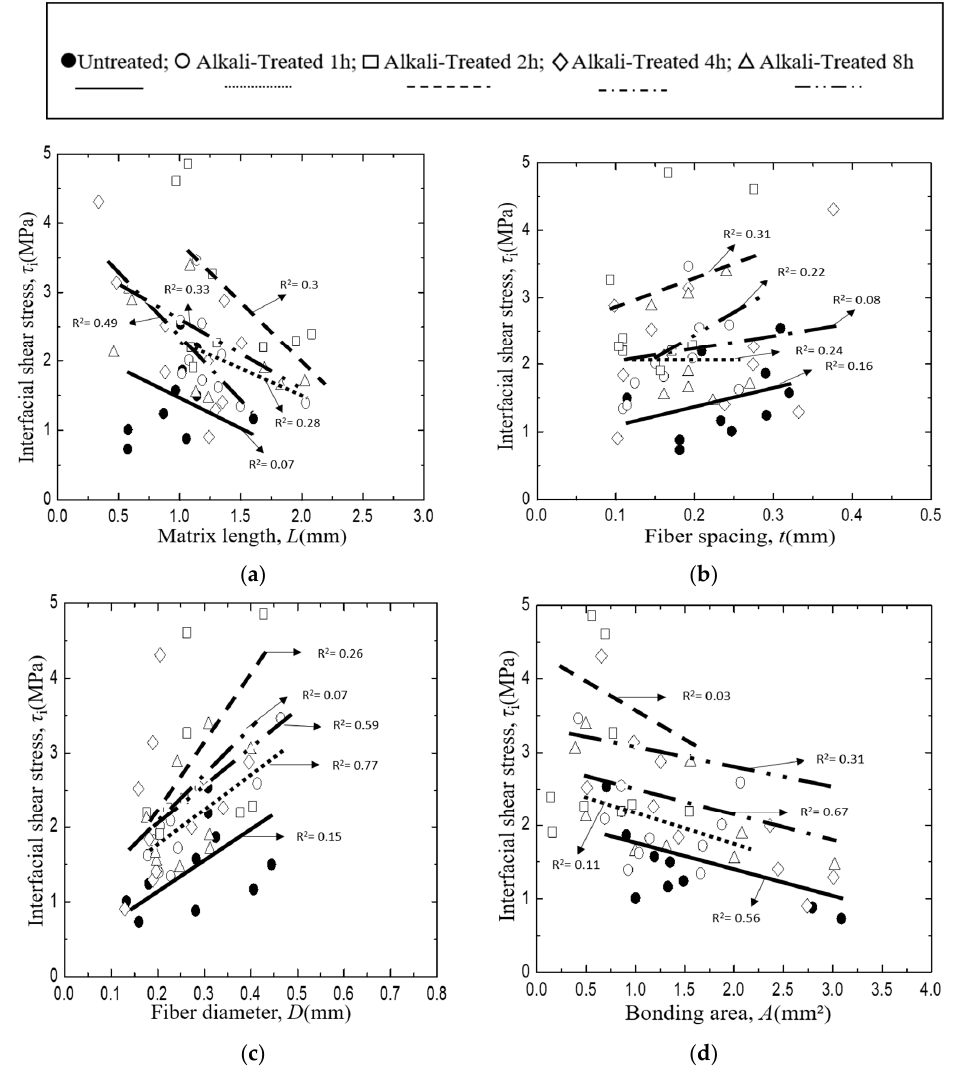
Figure 13. Interfacial shear strength of Typha spp. /Epoxy, where: ( a ) Matrix length, ( b ) Fiber spacing, ( c ) Fiber Diameter, ( d ) Bonding area.